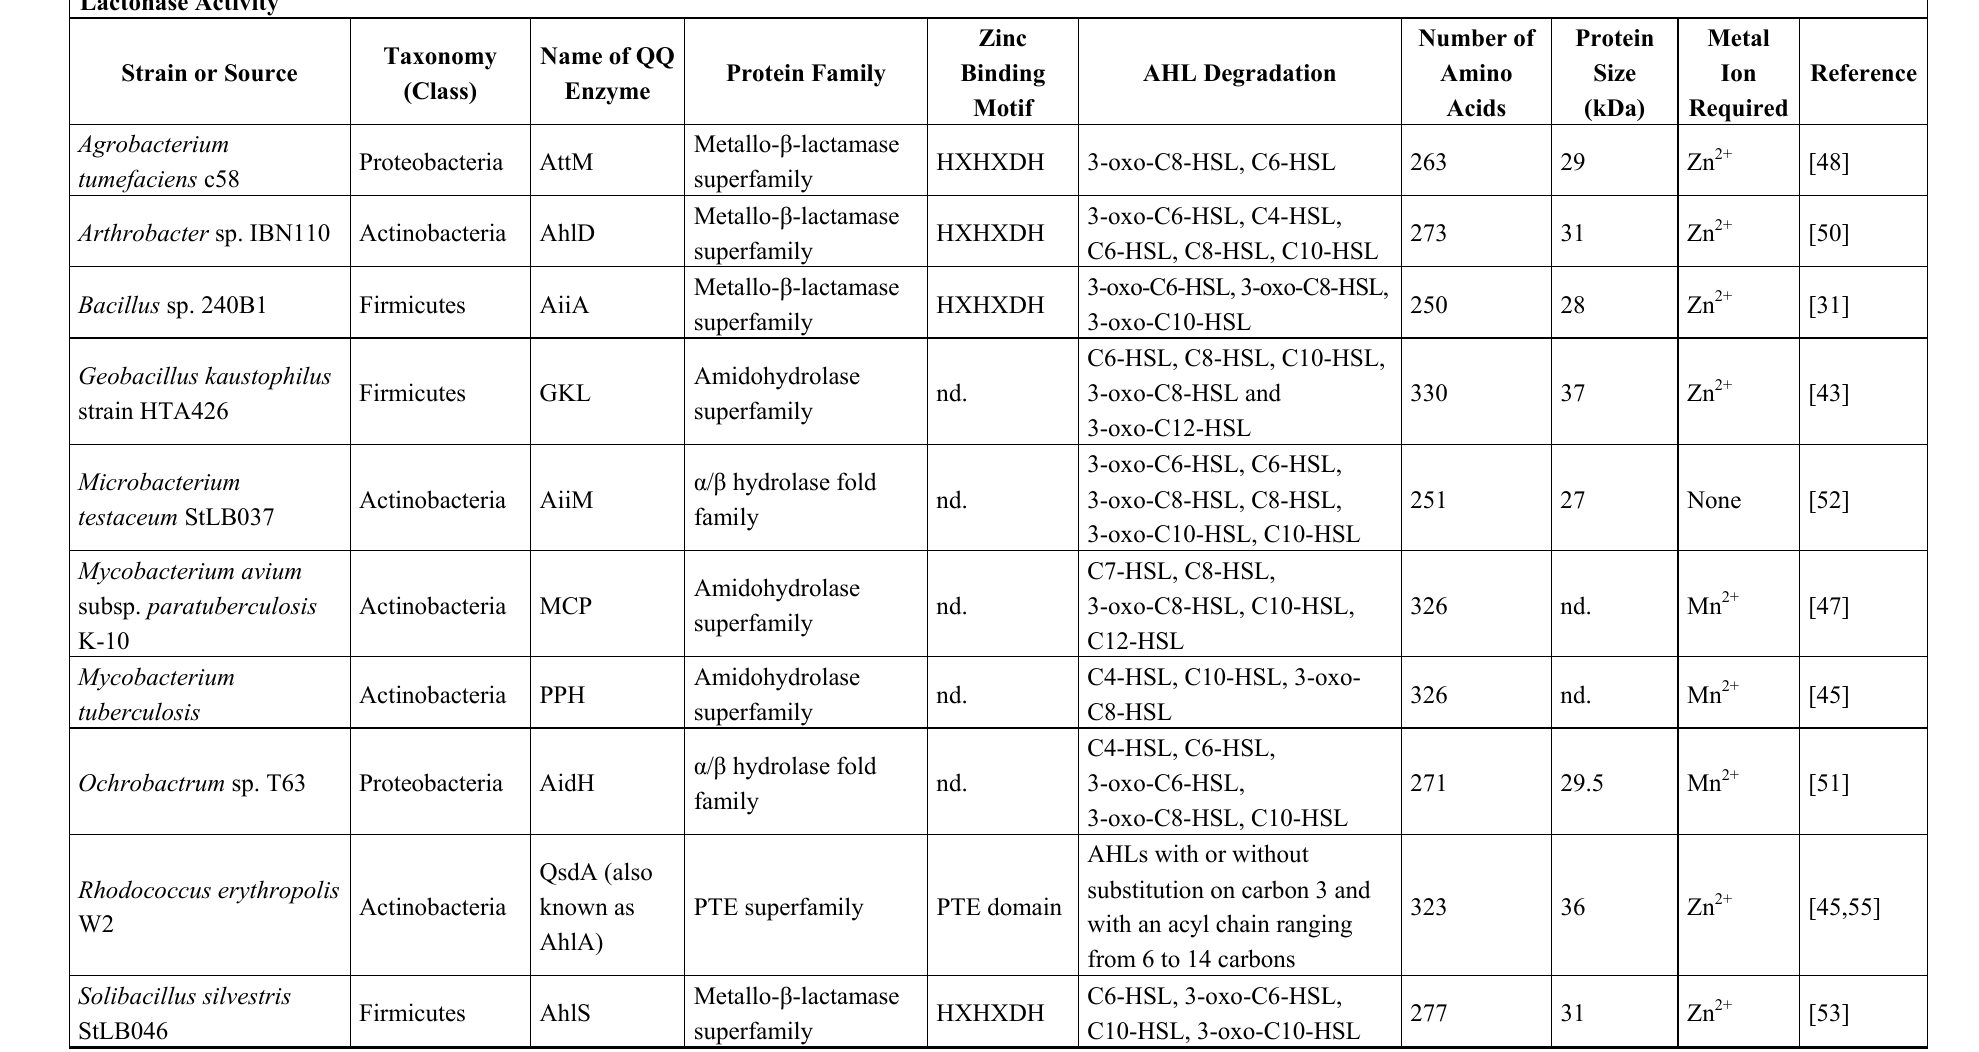
Table 1. Characterization of various microbial AHL-degrading